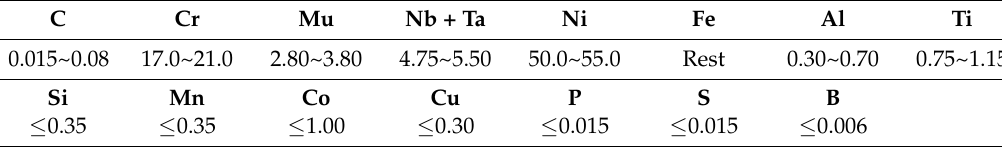
Table 2. Chemical composition of the GH4169 superalloy (wt%).